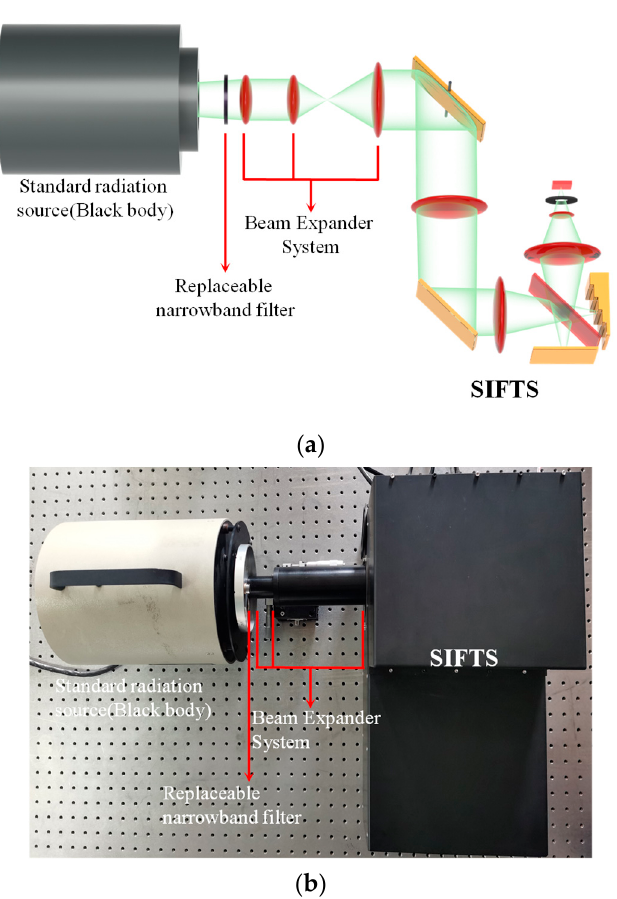
Figure 8. ( a ) Schematic of the laboratory calibration system. ( b ) Photograph of the laboratory calibration system with a layout corresponding to ( a ).